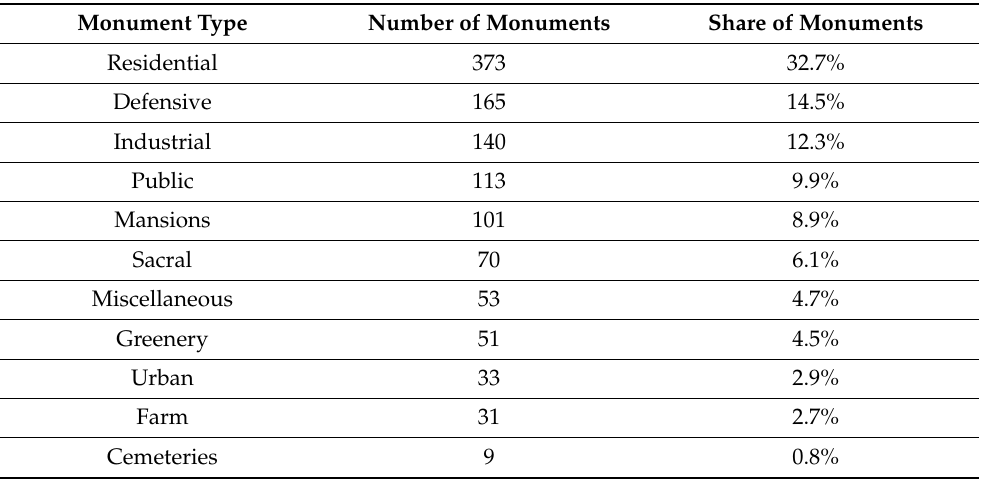
Figure 2. The study area of Tri-City. Source: own elaboration using ArcGIS Pro 2.7, on the basis of the data from The National Heritage Board of Poland and Polish National Register of Borders [31]. Table 2. Summary of monument types by NHBP division, within the Tri-City agglomeration. Source: own